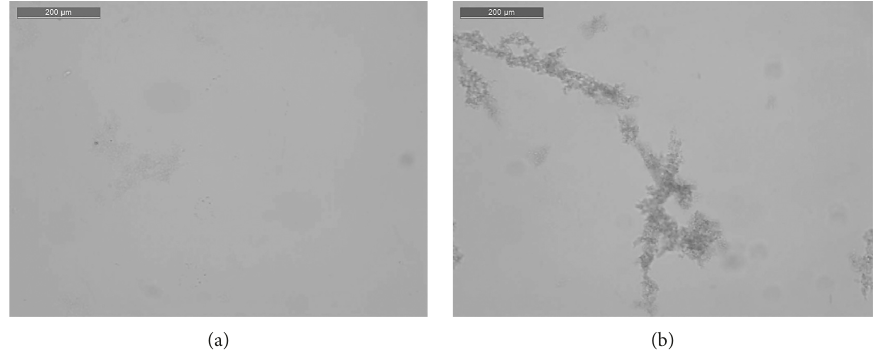
Figure 4: Microscopy images of CMC/CS hydrogel at ratios: (a) 200 and (b) 32.